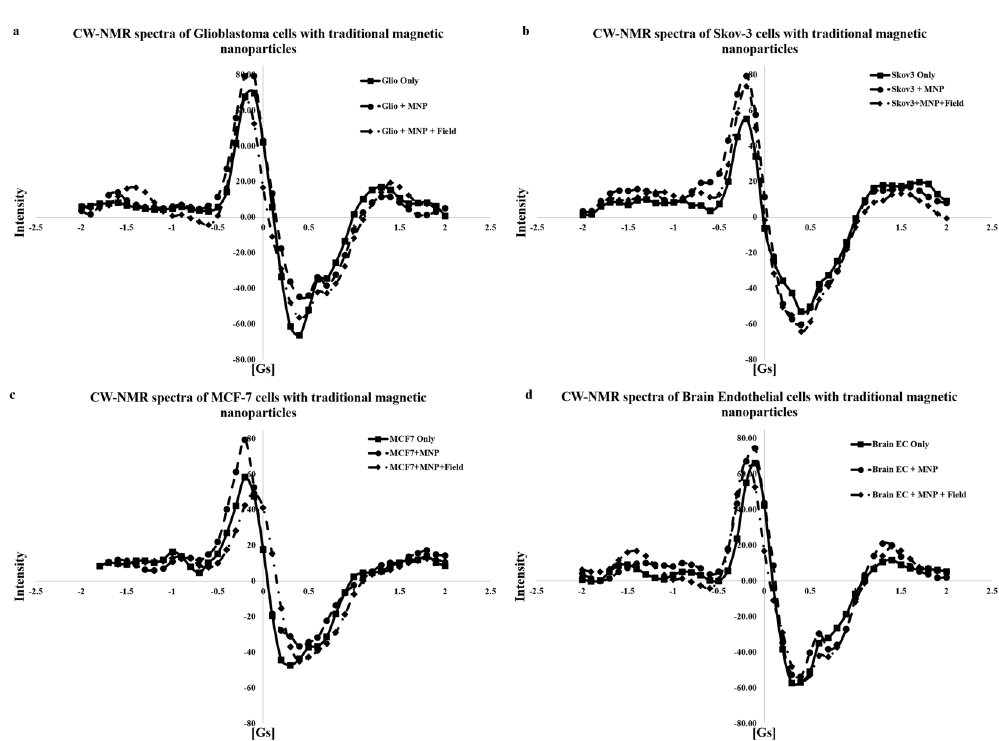
Figure 3. CW-NMR spectra including cells only, cells incubated with MNPs without and with application of a 100-Oe d.c. field for ( a ) glioblastoma cells U87-MG, ( b ) ovarian carcinoma cells Skov3, ( c ) breast adenocarcinoma cells MCF-7, respectively, and ( d ) normal brain endothelial